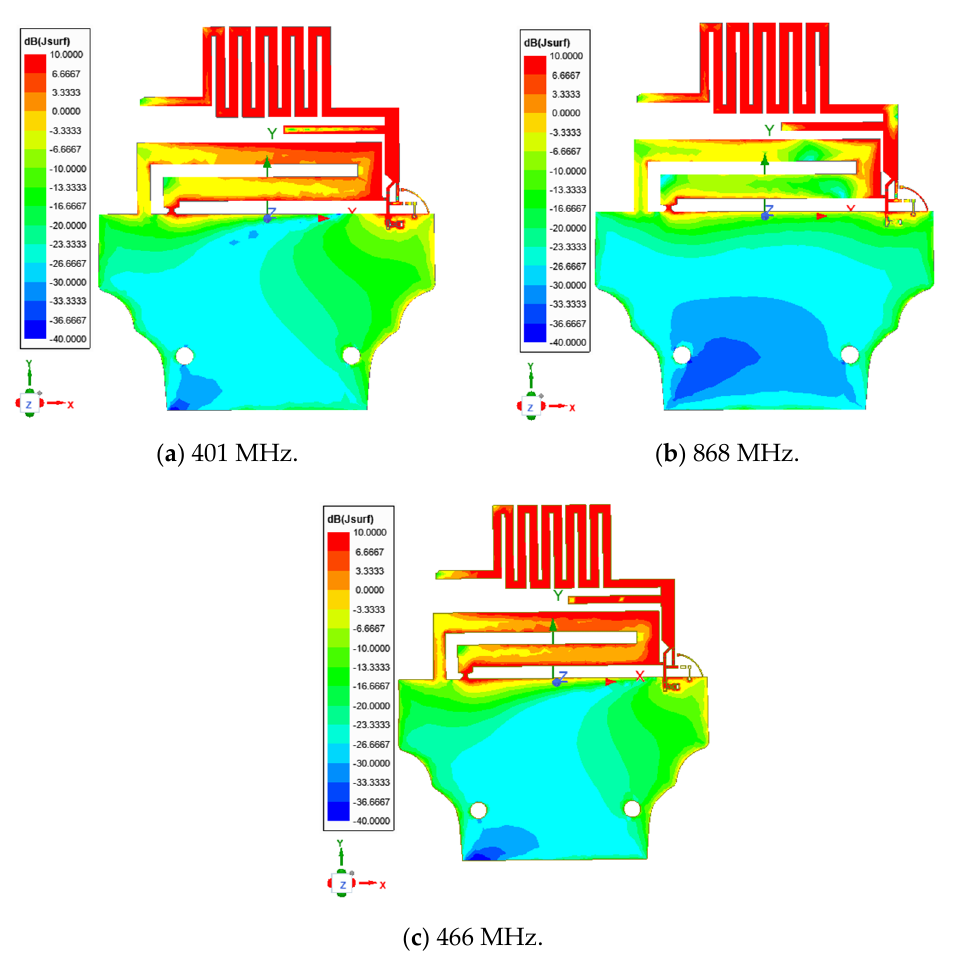
Figure 9. Current distributions: ( a ) at 401 MHz (OFF state); ( b ) at 868 MHz (OFF state) ;( c ) at 466 MHz (ON state).